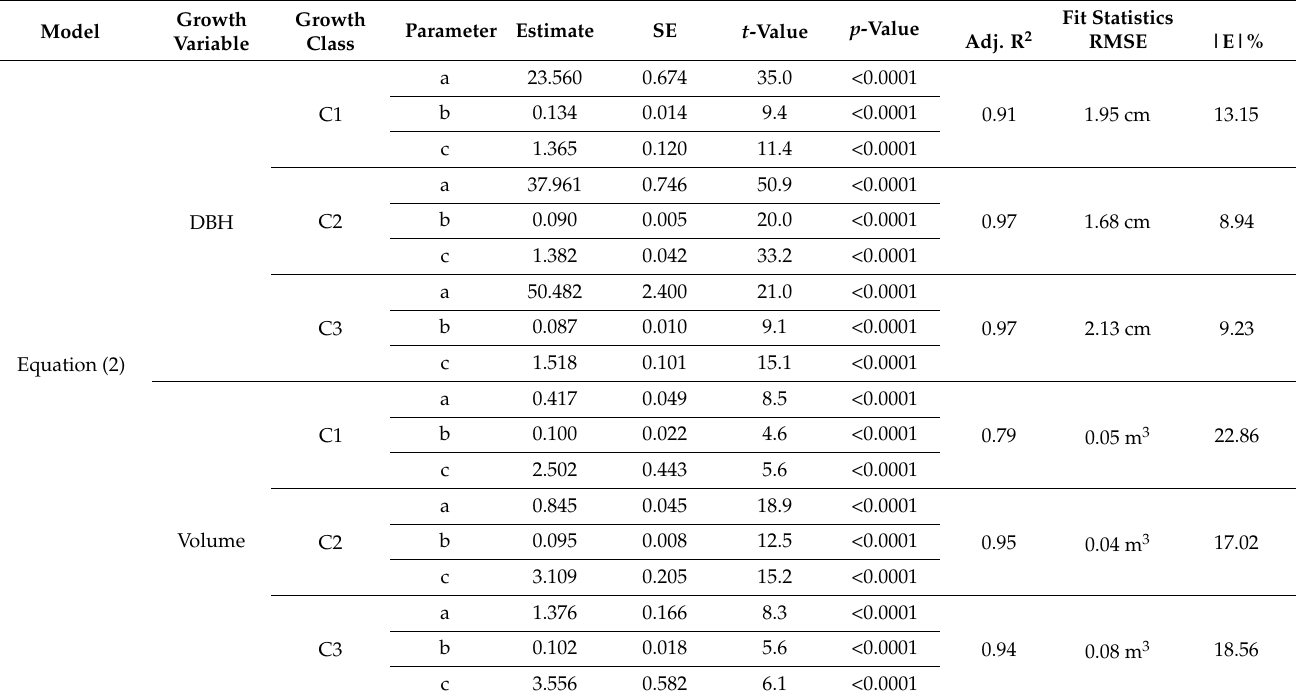
Table 3. Parameters and fit statistics for Equation (2) that was used to estimate the cumulative diameter and wood volume of three growth classes of P. patula trees. C1: 15–24 cm; C2: 25–34 cm; C3: 35–45